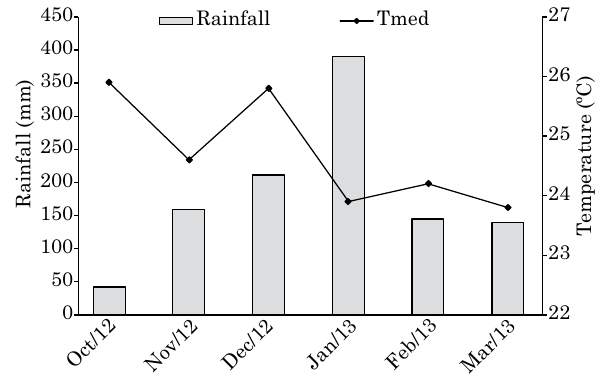
figure 1. mean monthly rainfall and temperature in the 2012/2013 growing